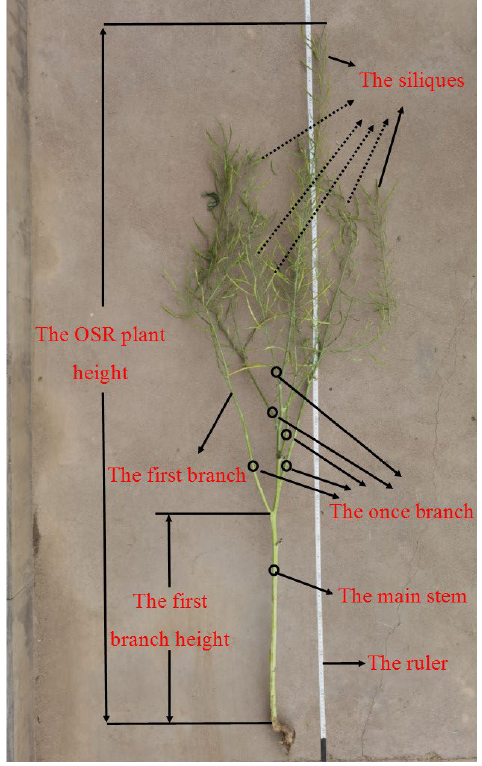
Figure 3. The OSR growth traits shown on a measured plant.